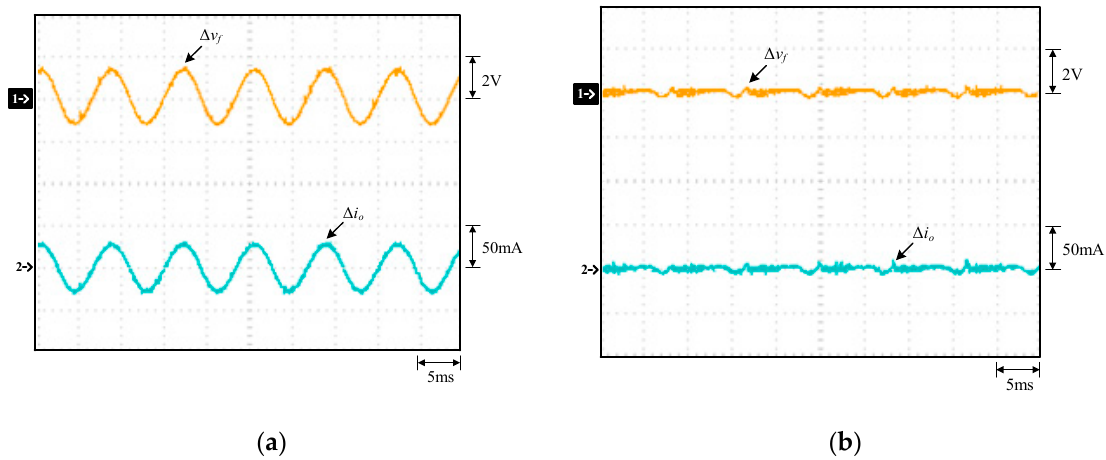
Figure 7. Waveforms under 110 V input voltage and 100% output load: ( a ) without; ( b ) with the proposed low-frequency current ripple improved: (1) v ac ; (2) i ac .